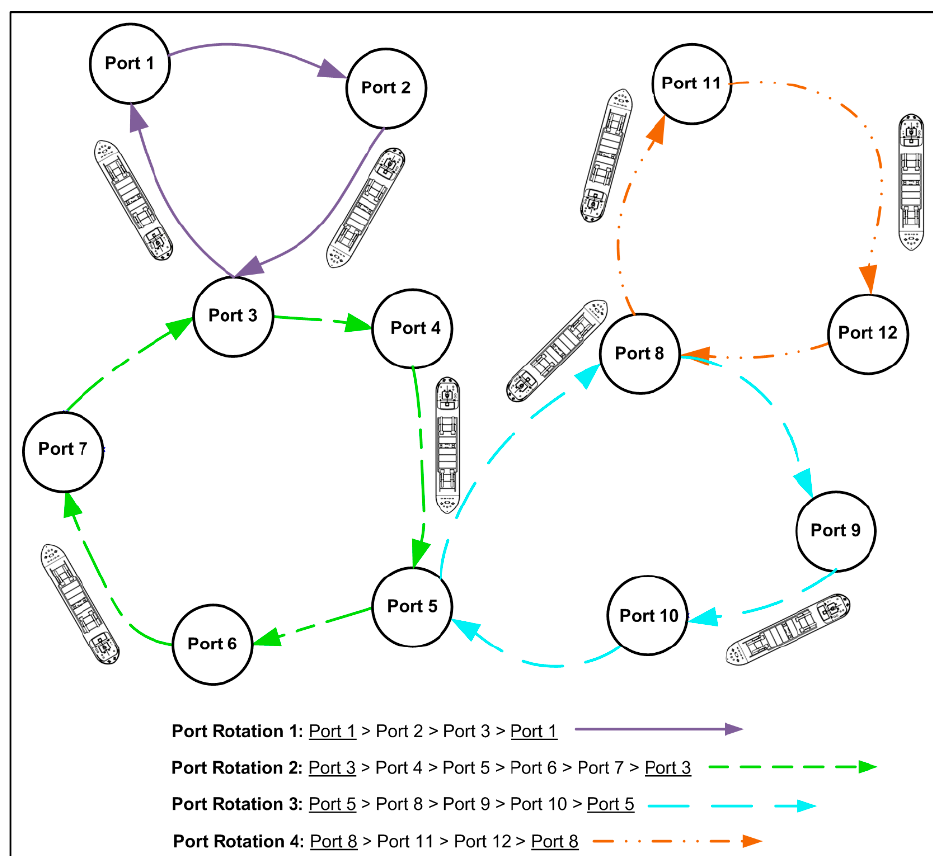
Figure 4. Illustration of an example shipping